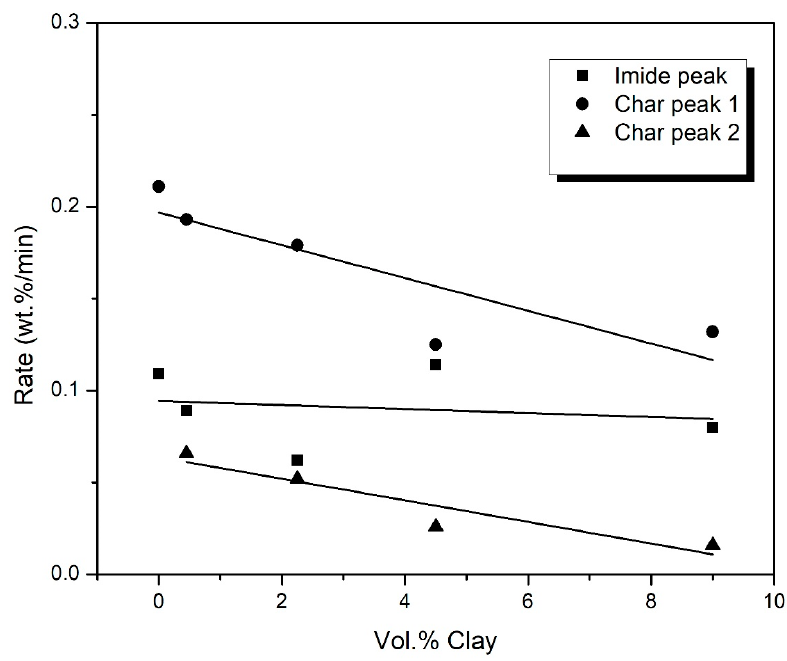
Figure 9. Variation of the rate of degradation of the imide unit and the char for PI-NGS-Clay nanocomposites, as a function of the vol.% clay.